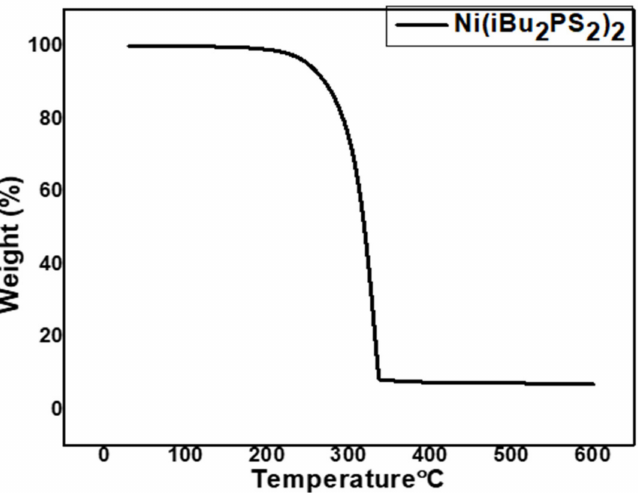
Figure 1. TGA runs of [Ni(iBu 2 PS 2 ) 2 ].